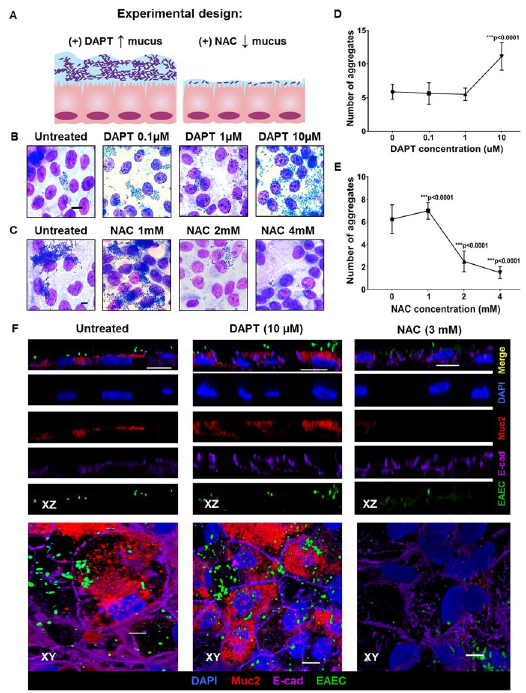
Fig 5. : EAEC adherence is dependent upon host intestinal mucus. (A) Experimental design explaining the chemical treatment performed to manipulate intestinal mucus and (B) showing increasing EAEC aggregative adherence to HIEMs with increased mucus production as induced by DAPT (a gamma secretase inhibitor). (C) EAEC clusters on HIEMs in the presence of N-Acetyl Cysteine (NAC), a mucolytic agent. (D-E) Quantification of EAEC aggregates in response to increasing doses of DAPT and NAC was quantified from average of 12 images taken at 100x and with field size of 2560x1920 pixel. Tukey’s multiple comparison test was performed, error bars denote SED and ��� indicates significantly different (P < 0.001). (F) shows representative confocal micrographs of HIEMs stained with fluorescent indicators for nuclei (DAPI, blue), MUC2 (Red), E-cadherin (Purple) and EAEC (GFP, green). HIEMs were infected with EAEC A2A:GFP that were treated with DAPT (10 μ M) and NAC (3 mM). Representative of over 50 images. Scale bars indicate 10 μ m.